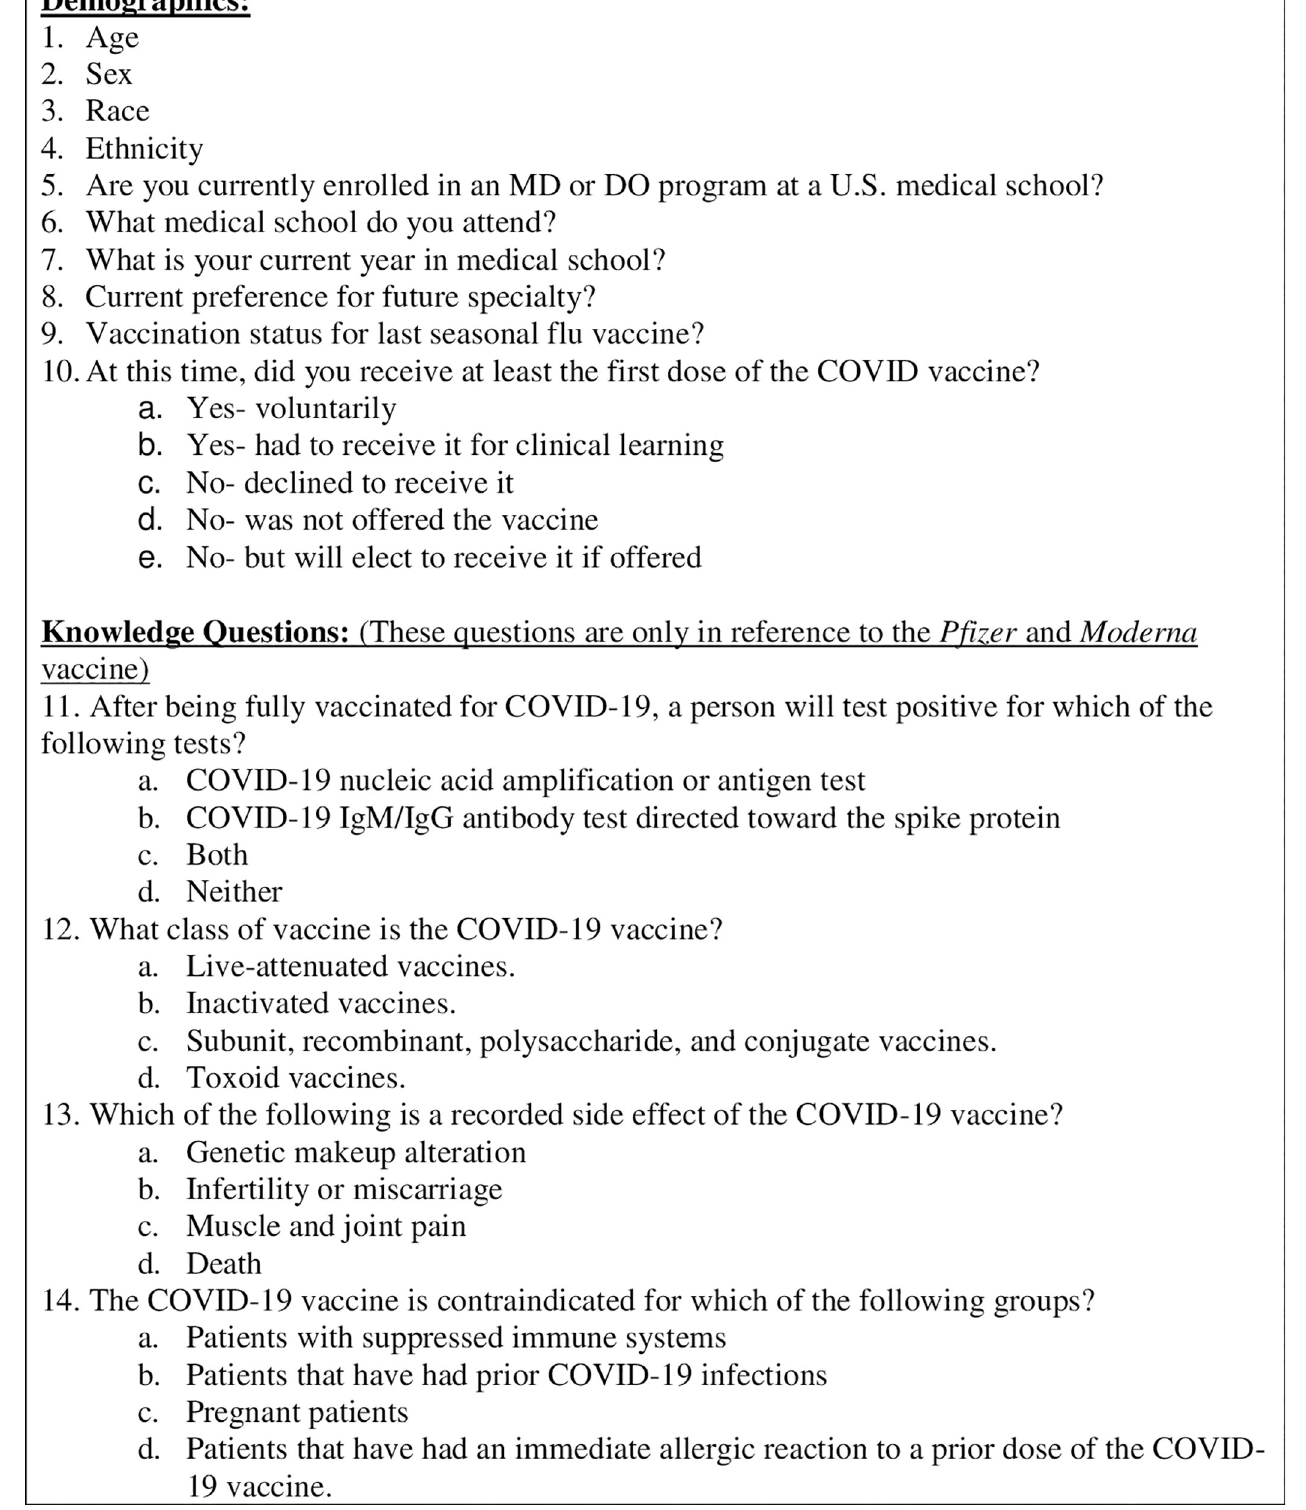
Fig 1. COVID-19 vaccination survey.